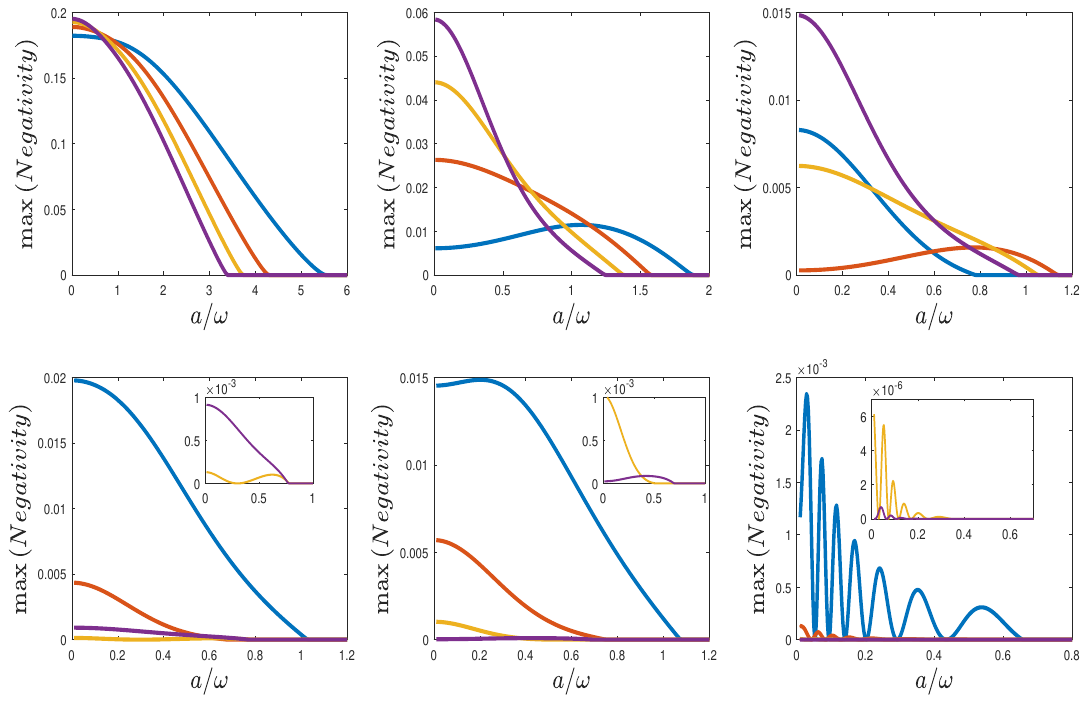
Figure 8 . Changes of maximal Negativity with acceleration for different atom separations. The six subfigures stand for L = 0 . 3 , L = 2 , L = 3 , L = 4 , L = 4 . 4 , and L = 30 respectively from left to right and top to bottom. Blue, red, yellow and purple lines stand for D = 3 , D = 4 , D = 5 , and D = 6 ,